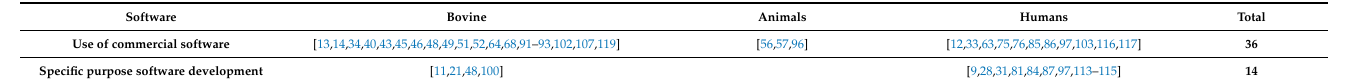
Table 5. Result of comparing related job–software